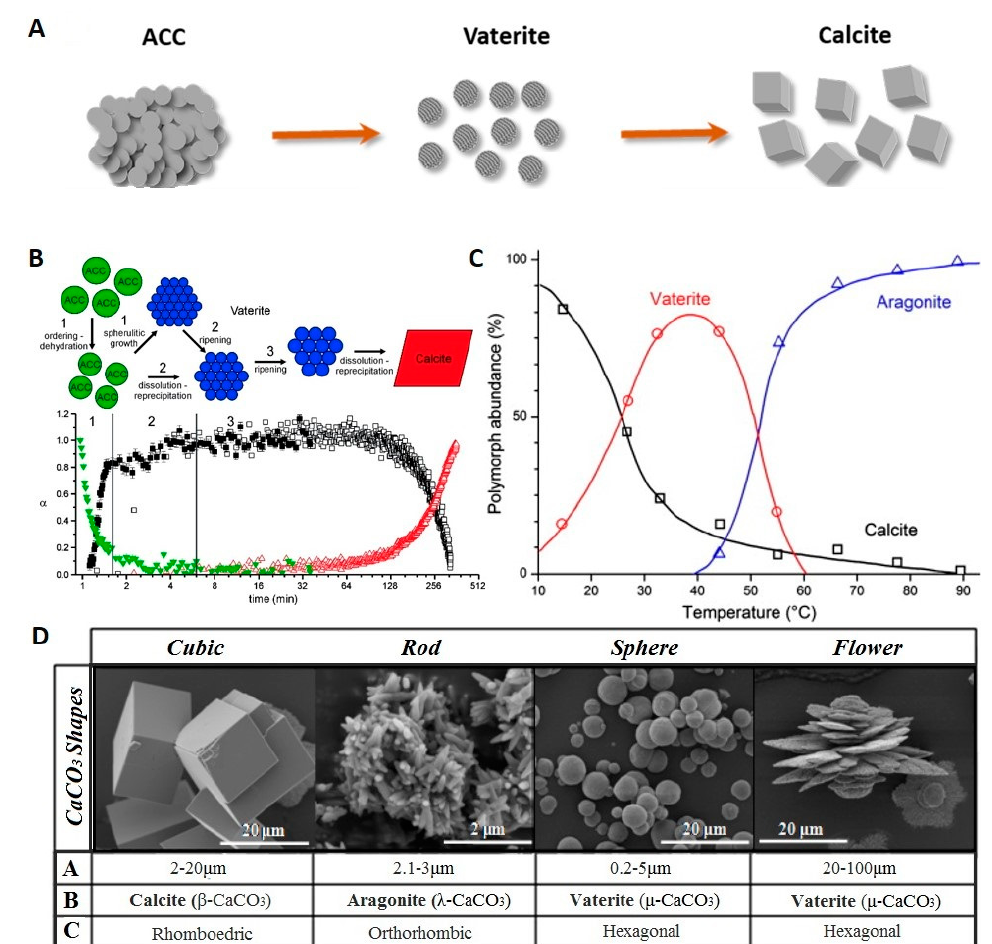
Figure 4. ( A ) Schematic illustration of CaCO 3 crystallization process; ( B ) Schematic representation of ACC-vaterite-calcite crystallization pathway for the full crystallization reaction in the pure ACC system (the green triangles and full black squares represent the ACC and vaterite from this study, and the open squares and red triangles represent the vaterite and calcite). Reproduced with permission from [92]. American Chemical Society, 2012; ( C ) initial polymorphic composition of CaCO 3 in dependence of the temperature. Reproduced with permission from [94]. Elsevier, 2014; ( D ) the typical shapes of calcium carbonate (CaCO 3 ) particles. (A: Average Diameter; B: Crystalline Phase; C: Crystalline System). Reproduced with permission from [97]. MedCrave,